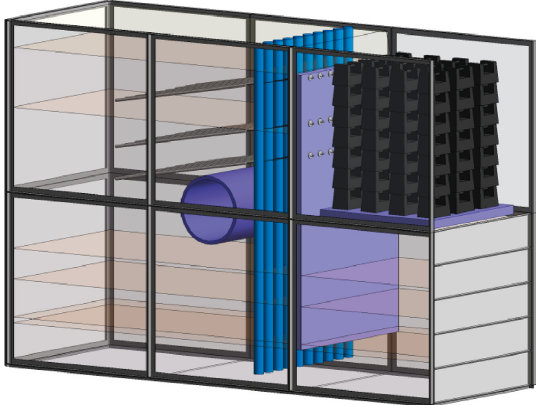
Figure 7: Diagram of procedure 20.